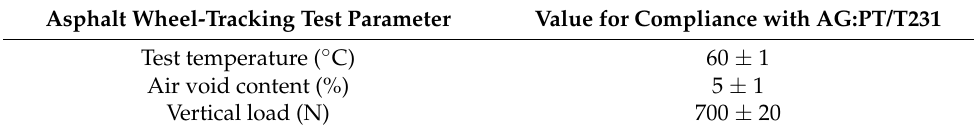
Table 10. Four-point beam bending test parameters from AG:PT/T233 Reprinted from ref. [17].